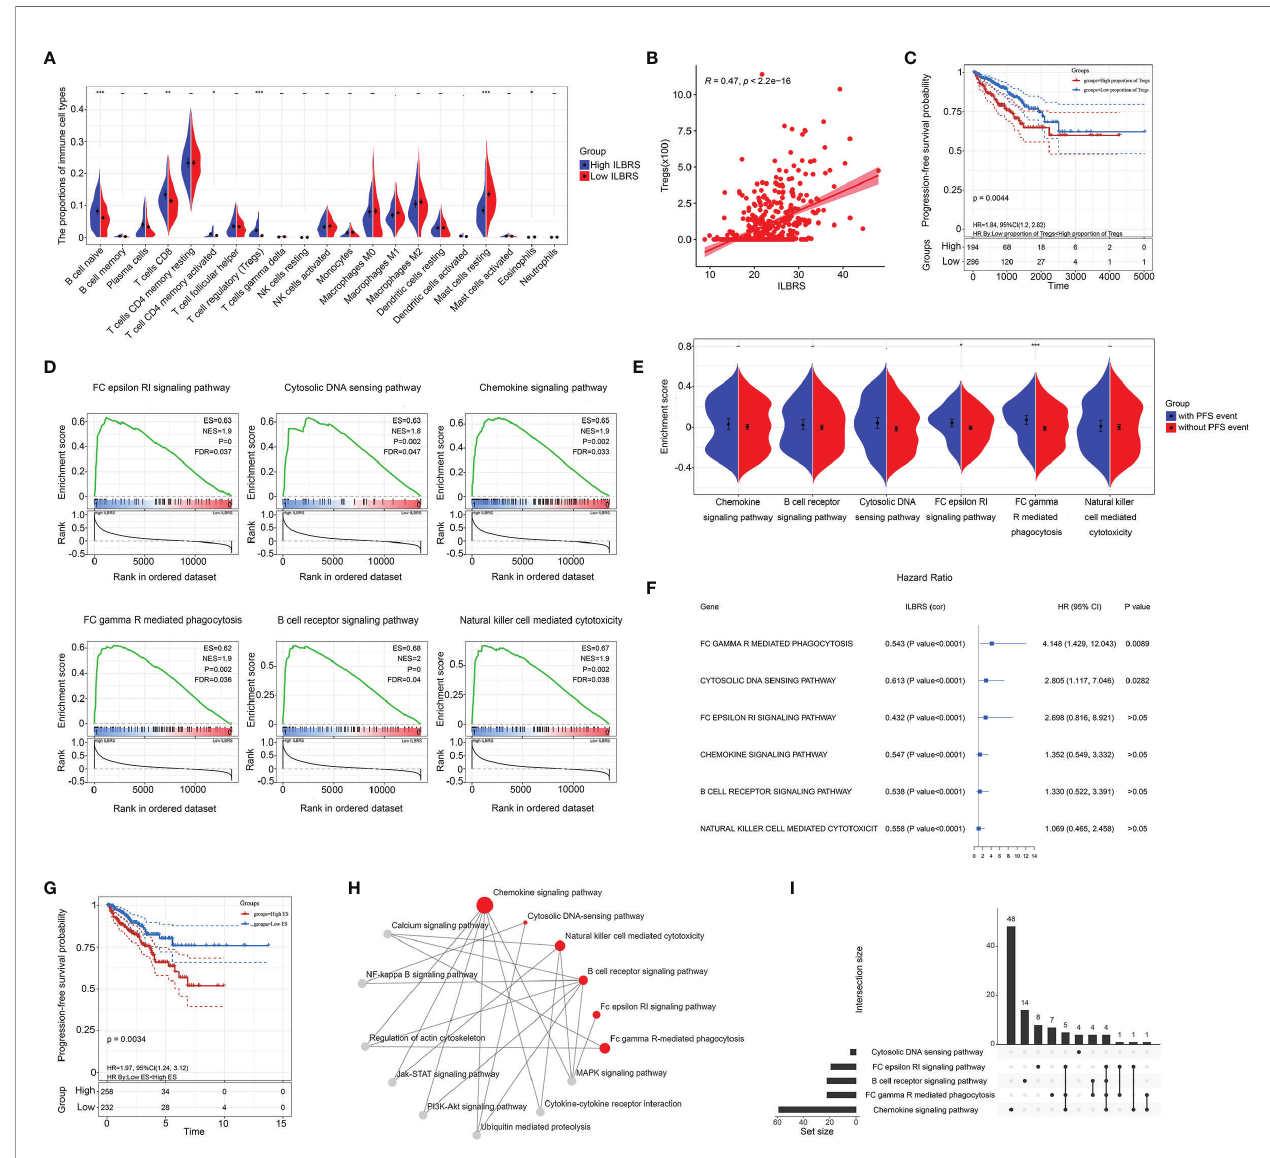
FIGURE 3 | ILBRS-relevant immune cell in fi ltration and immune-relevant KEGG pathways. (A) The proportions of 22 immune cell types in high and low ILBRS patient groups in TCGA-PRAD data. (B) Pearson correlation analysis of ILBRS and Tregs in fi ltration. (C) Kaplan – Meier curves for the PCa tissues from patients with high and low Tregs in fi ltration in TCGA-PRAD data. (D) KEGG pathway analyses show a notable pathway of the gene signature. (E) PFS event risk assessment for the ES of the immune-relevant KEGG pathways. (F) Forest plot of the results of univariate Cox regression analyses of the ES of the immune-relevant KEGG pathways. The square data markers indicate estimated hazard ratios (HR). The error bars represent 95% CIs. “ cor ” shows the coef fi cient gained through Pearson correlation analysis. (G) Kaplan – Meier curves for the PCa tissues from patients with high and low ES of FC gamma R-mediated phagocytosis in TCGA-PRAD data. (H) The immune-relevant KEGG pathway network. The red dots represent the six pathways. The gray dots are the intermediate pathways between two of the immune-relevant KEGG pathways. (I) Venn plot presenting overlapped genes among the immune-relevant KEGG pathways. * p < 0.05; ** p < 0.01; *** p <